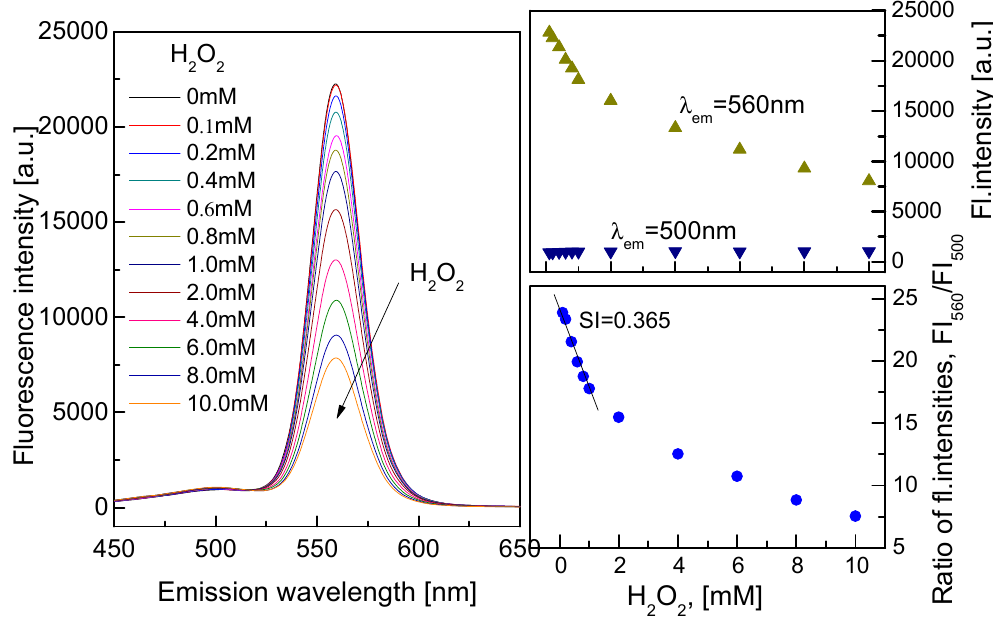
Figure 7. Fluorescence emission spectra of the HRP–QD–AF membrane with respect to H 2 O 2 concentrations in the range of 0.1–10 mM and calibration curve of the HRP–QD–AF